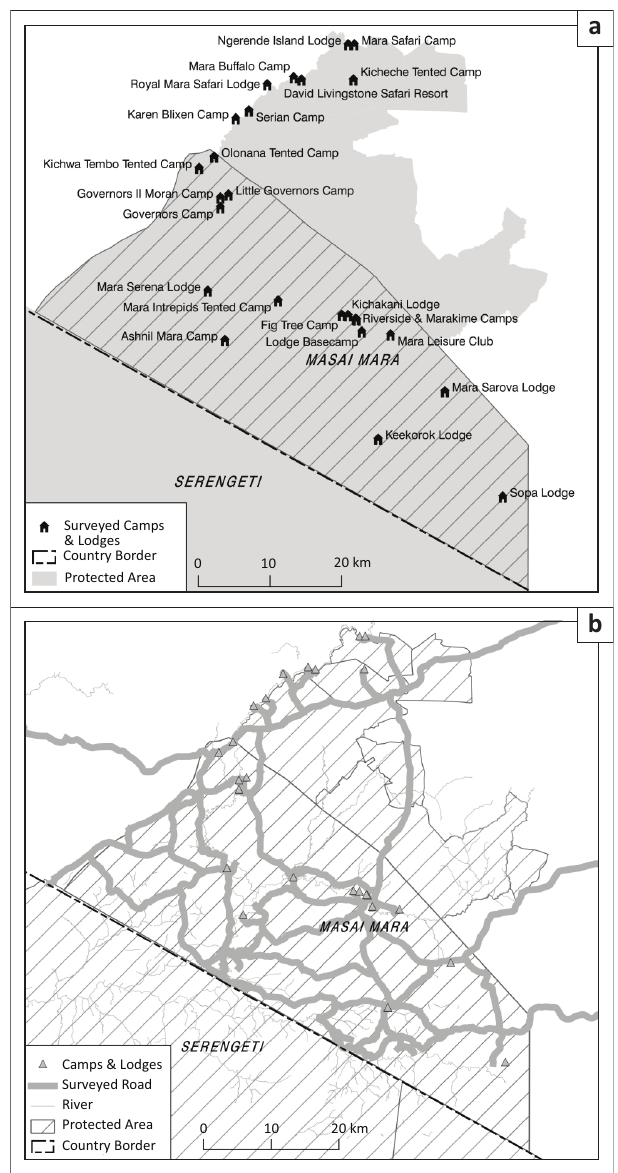
FIGURE 2: (a) Location of tourist nodes (lodges and other accommodation) in the Masai-Mara National Reserve and adjacent conservation areas that were surveyed for the occurrence of alien plant species and (b) roads in the area that were surveyed for the occurrence of alien plant